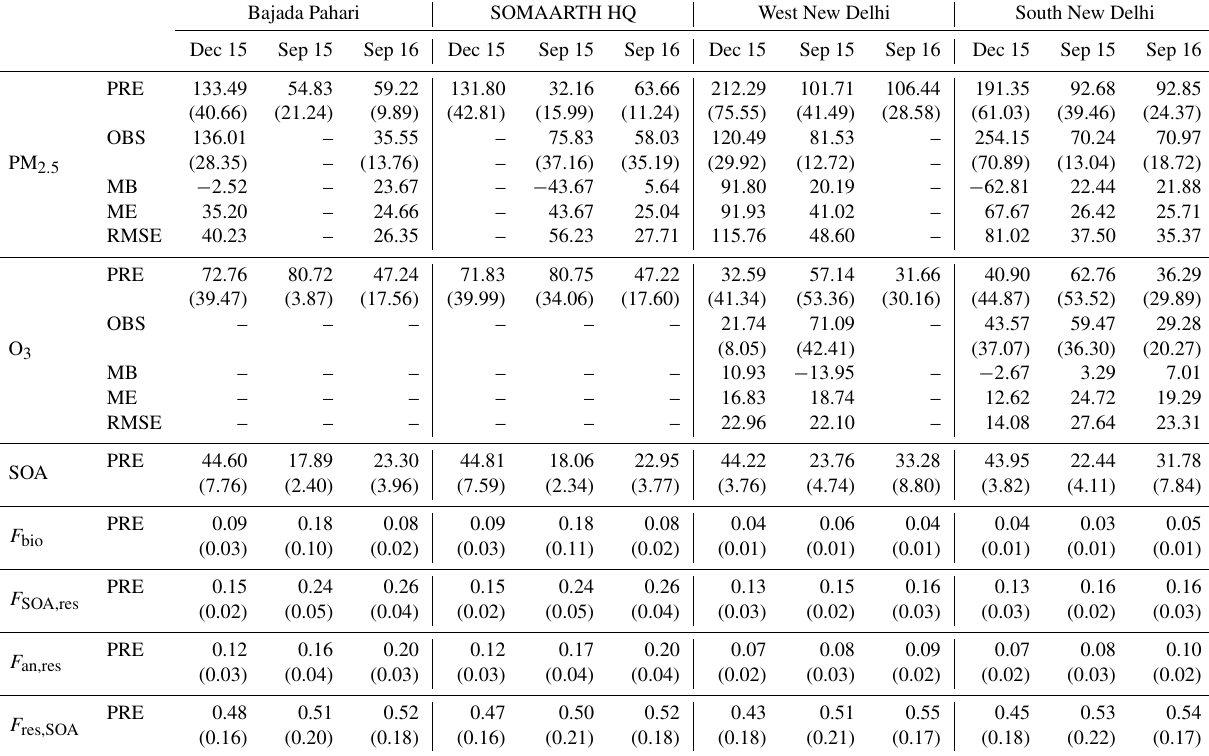
Table 10. CMAQ model performance and summary